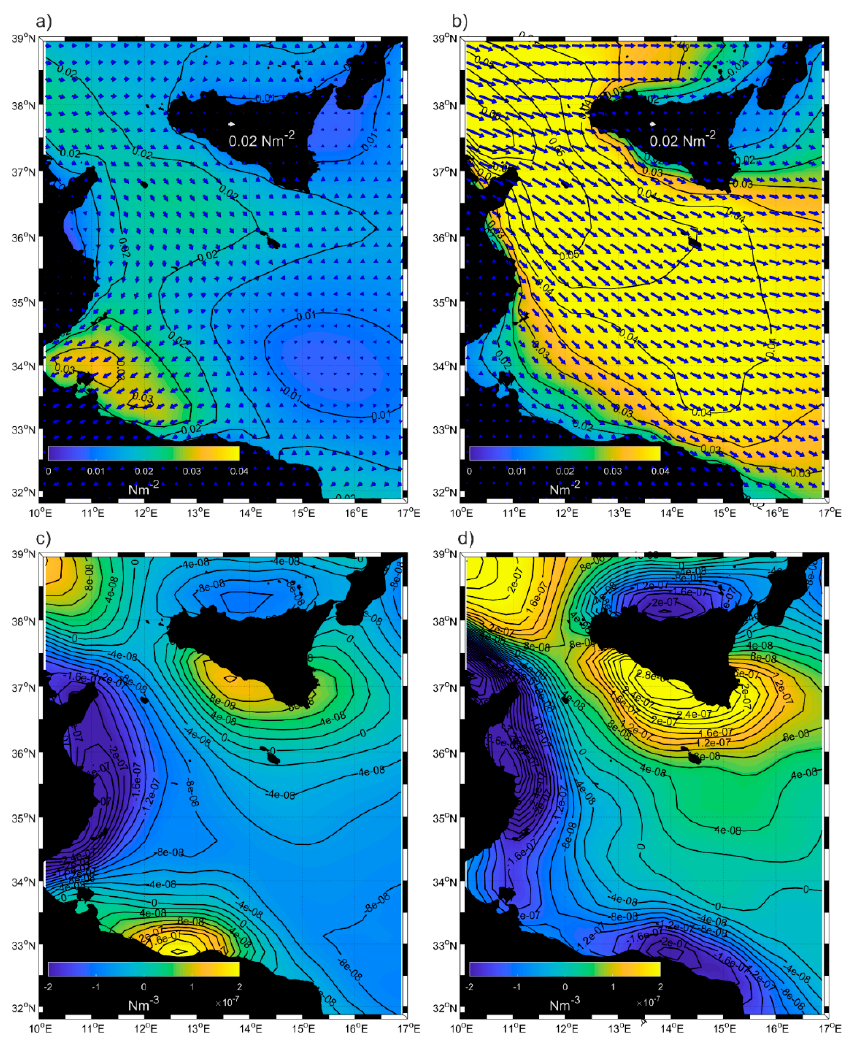
Figure 4. Mean map of the wind stress (upper panels) amplitude (colours) and direction (vectors) and ( d ) wind stress curl (lower panels) over the extended summer ( a , c ) and extended winter ( b , d ).